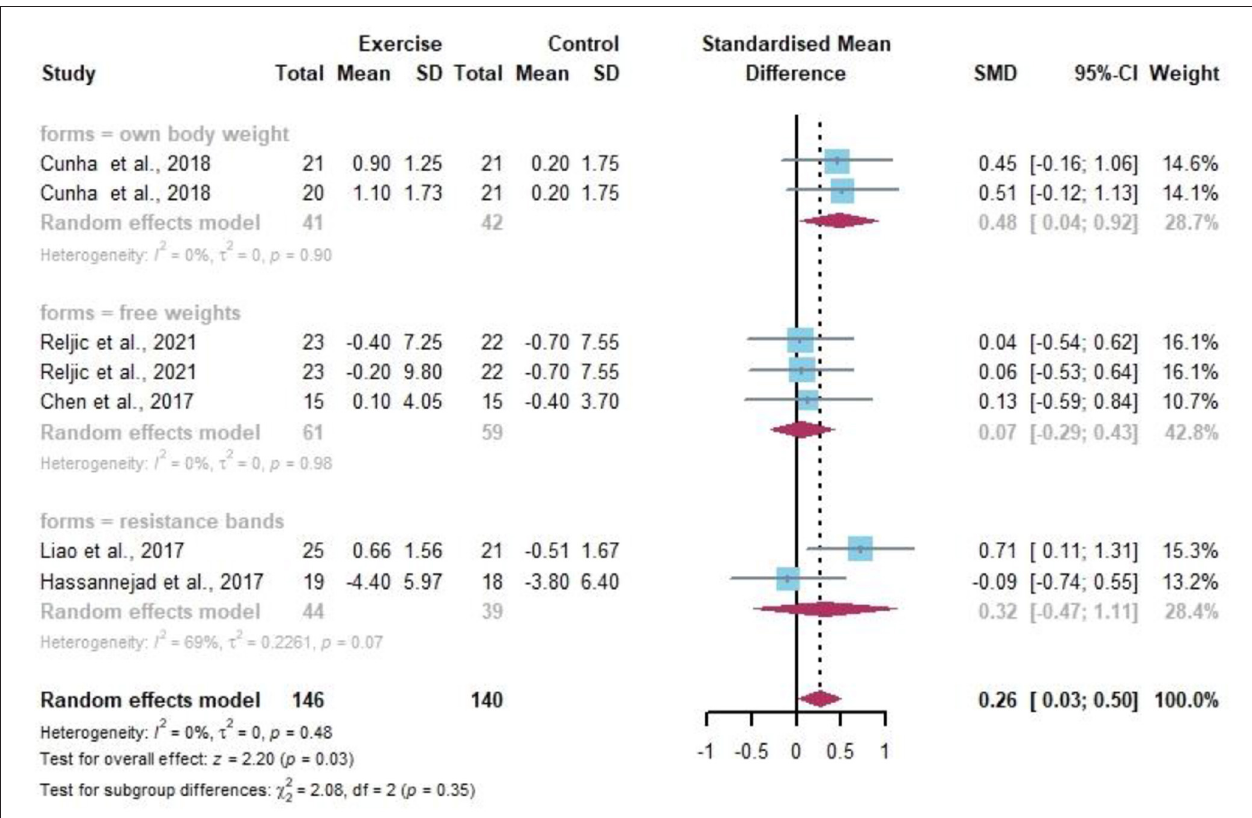
FIGURE 9 | Meta-analysis of effects of different resistance exercise forms on SMC of overweight and/or obese individuals.